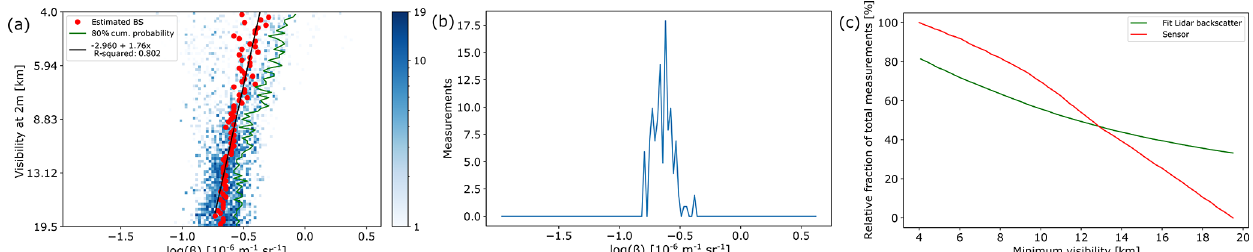
Figure 6. Visiometer readings versus lidar backscatter, for Cabauw; 39m (40m)a.g.l. for lidar (visiometer). Data cover the full range from 13 July 2018 to 29 February 2020. (a) The 2D histogram. Overlain are the centroid backscatter values (red dots), transfer function (black) and 80% cumulative probability (green) for each visibility. (b) The 1D slice at a visibility of 12km. (c) Relative fraction of total measurement for a given visibility using the fitted BS values and the visiometer data only.